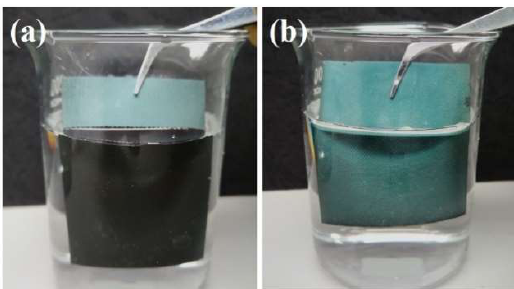
Figure 9. Photograph of SiO 2 ( a ) and HDTMS-SiO 2 ( b ) structurally colored fabrics immersed into water.